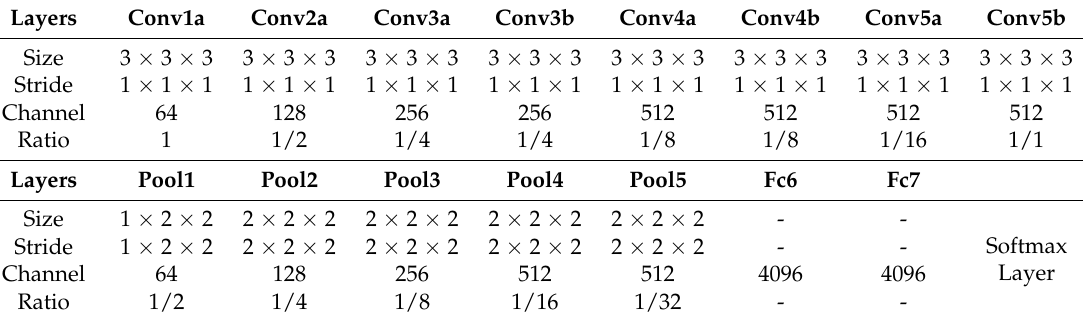
Figure 3. Complete Network architecture of C3D. Table 1. The convolutional and pooling layers of the C3D architecture.